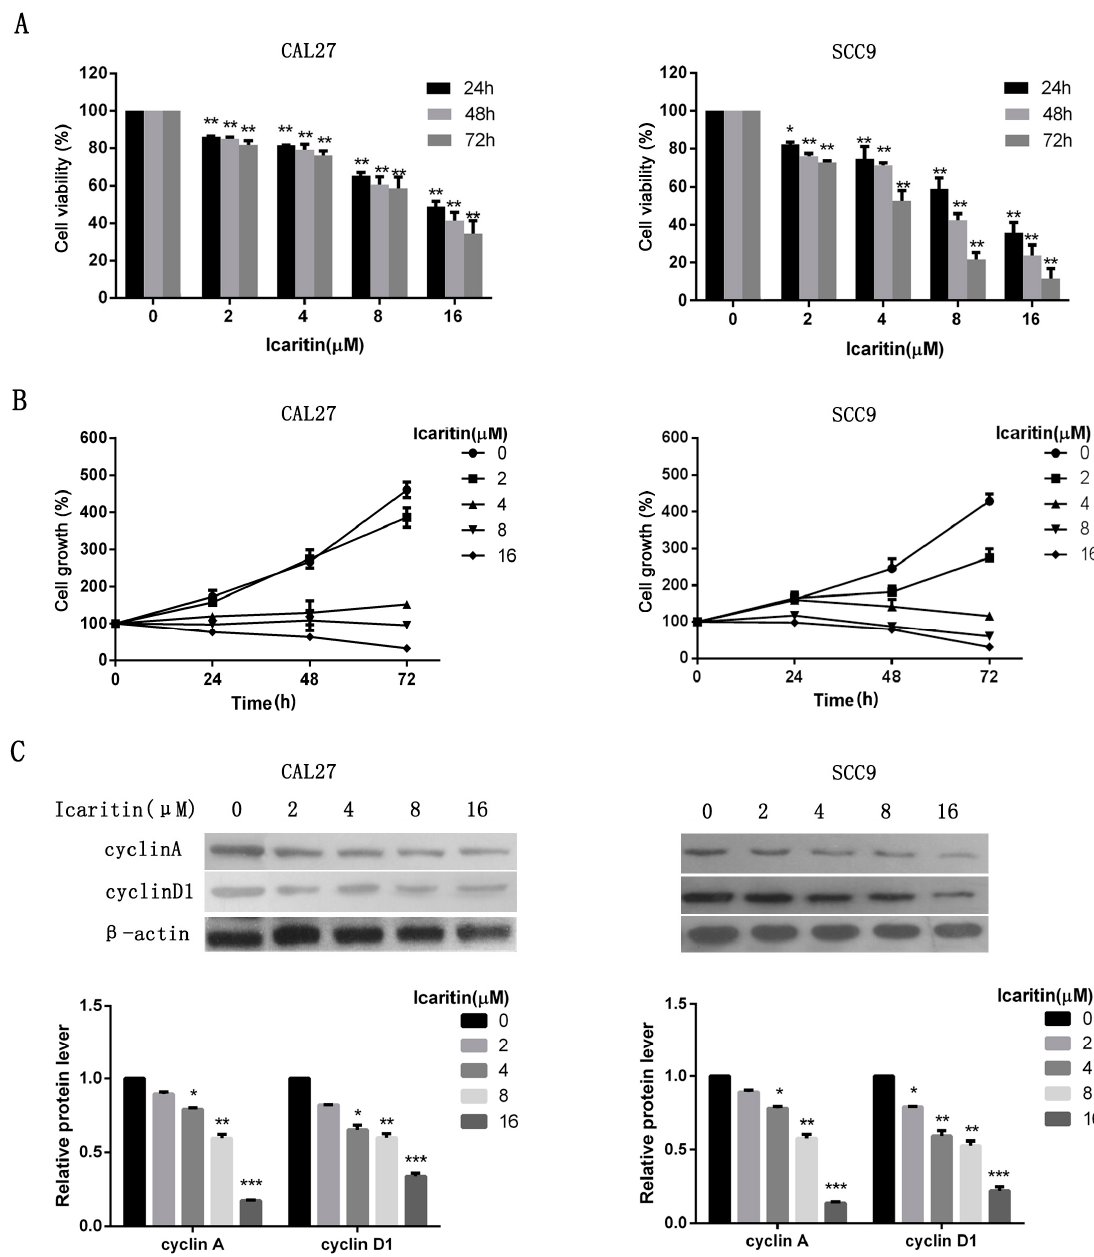
Figure 2. Icaritin inhibited OSCC cells proliferation. ( A , B ) Dose and time-response curves showing icaritin effects on OSCC cell lines growth inhibition. CAL27 and SCC9 cells were treated with icaritin at increasing concentrations (2, 4, 8, and 16 μ M) for 24, 48, and 72 h. Cell viability was evaluated by CCK-8 assay. Data were expressed as mean ± standard deviation (SD) ( n = 3, in triplicate). * p < 0.05; and ** p < 0.01 versus 0 μ M group; ( C ) Icaritin downregulated cyclin A and cyclin D1 expression, as evaluated by western blot. β -actin was used as a loading control. Relative density data of each protein was quantified by β -actin using Image J, and the data represented the mean of three independent experiments. * p < 0.05; ** p < 0.01; and *** p < 0.001 versus 0 μ M group.